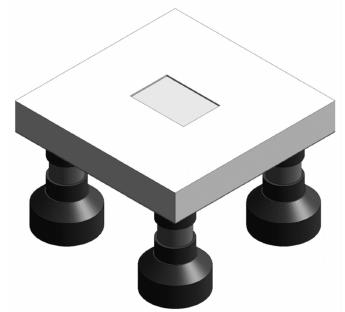
Figure 5. CAD model of the “base” Configuration of the floating platform. Froude